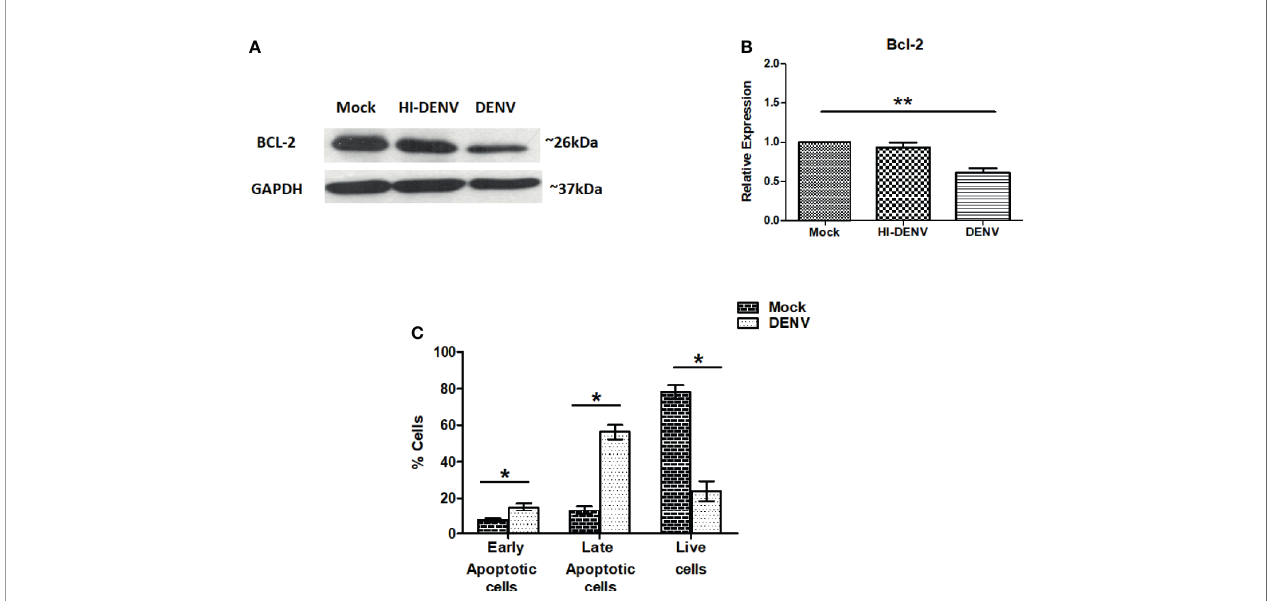
FIGURE 4 | DENV infection leads to apoptosis in MEG-01 cells. (A, B) Immunoblotting of Bcl-2 protein in mock-infected, DENV inactivated virus treated, and DENV infected MEG-01 cell lysate and represented as column graphs. (C) DENV infected and control MEG-01 cells were stained with FITC conjugated Annexin-V and Propidium Iodide and analyzed on fl ow cytometer. Graph representation of early apoptosis (only Annexin-V positive cells), late apoptosis (Annexin-V + PI positive cells), and live cells (double negative cells). (*pValue < 0.05; **pValue <